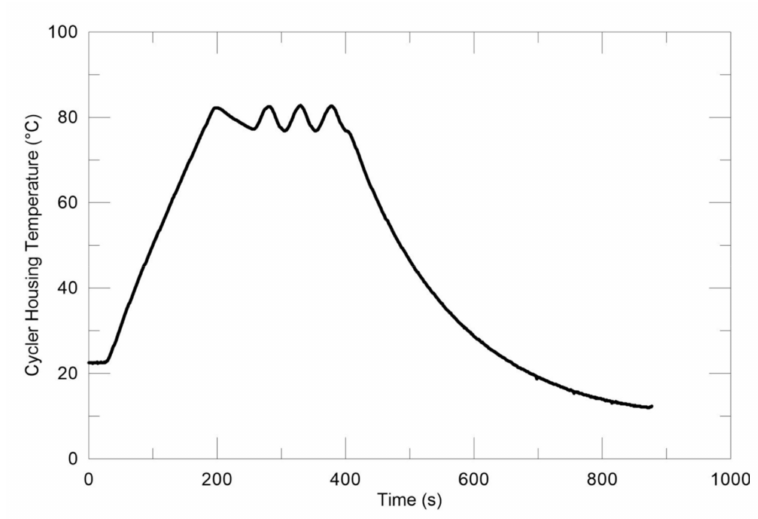
Figure 12. Typical temperature–time profile of stability testing device